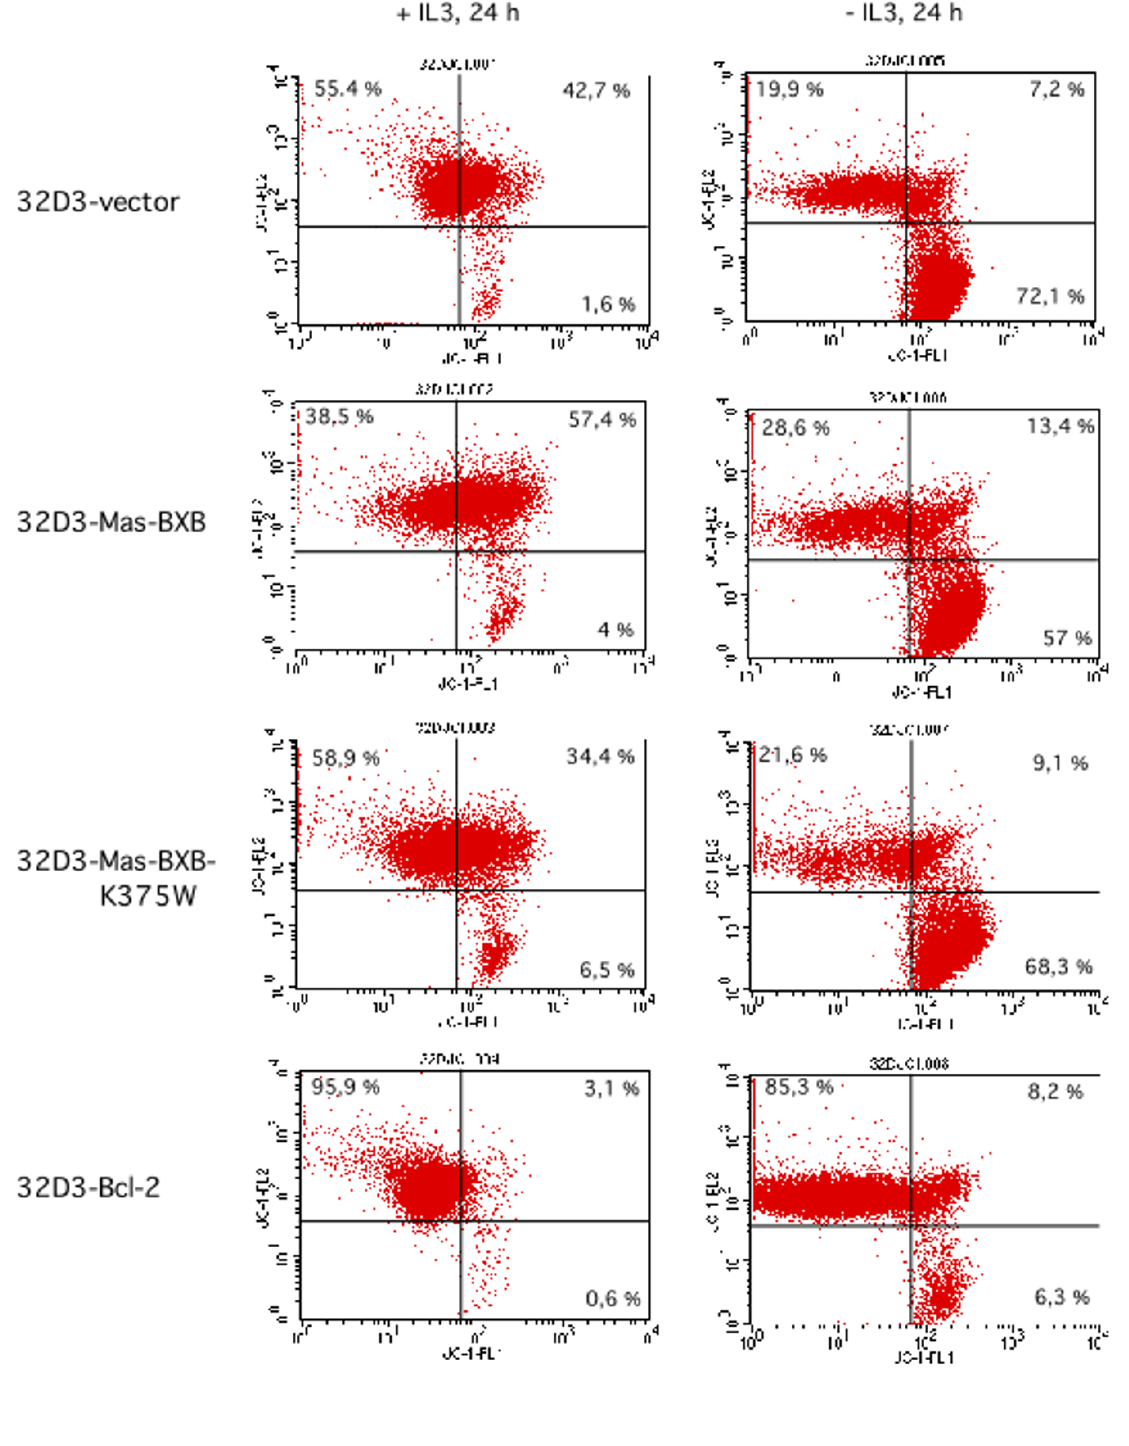
Figure 2 C-Raf delays the mitochondrial membrane depolarization occurring during apoptosis . 32Dcl.3 transfected cells were cultured with or without IL-3 for 24 hours, incubated with JC-1 cationic dye and washed with PBS before flow